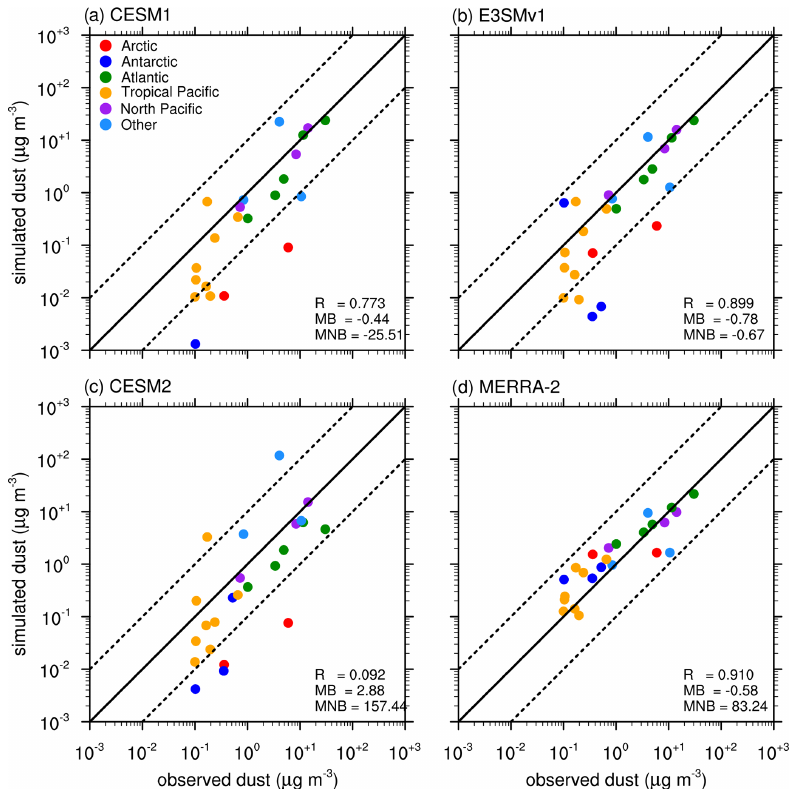
Figure 9. Observed and simulated annual mean dust surface concentrations (µgm − 3 ) at 24 sites. The measurements at Alert are from Fan (2013); the observations at Heimaey, Barbados, and Miami are from Prospero et al. (2012); the dataset for the other 20 sites are from Huneeus et al. (2011). These sites were operated by the University of Miami (Arimoto et al., 1996; Prospero et al., 1989; Prospero, 1996). Different color represents different